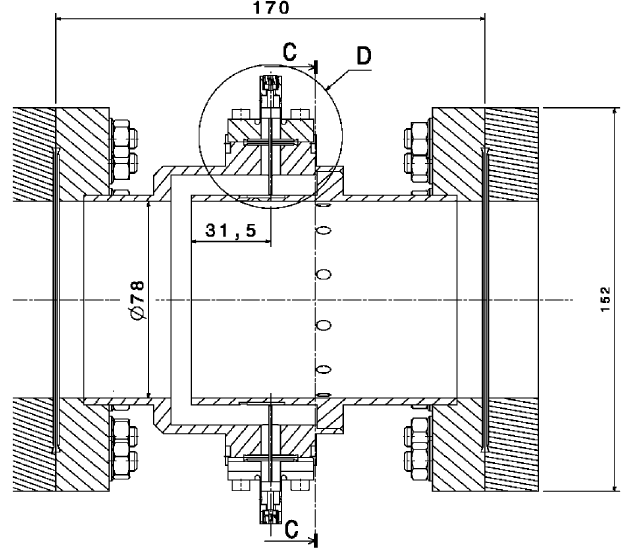
FIG. 5. Drawing of the modified cavity